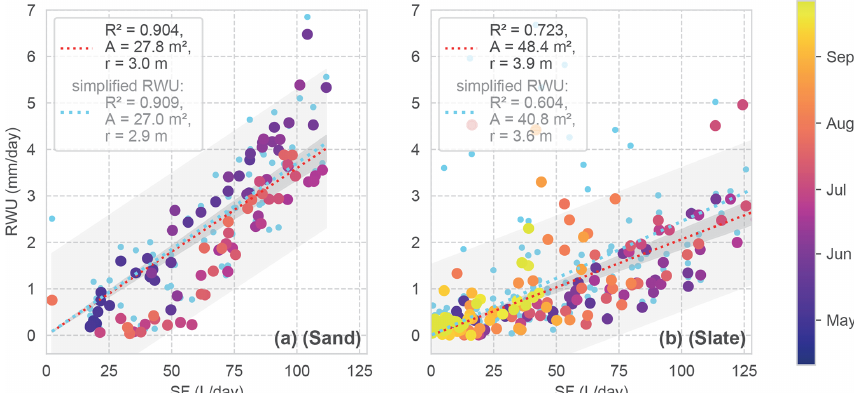
Figure 8. Daily RWU in relation to SF for both sites. The colour coding corresponds to the day of the year. Linear regression models are given as dashed lines. The grey shading shows the predicted and observed confidence intervals. The linear regression model is assumed with zero intercept, resulting in a scaling factor which is reported as the mean area ( a ) and radius ( r ) of a hypothetical cylindrical rhizosphere in the legend (possible storage in the tree is neglected). The light blue dots and regressions refer to RWU estimates with the simplified RWU calculation approach for